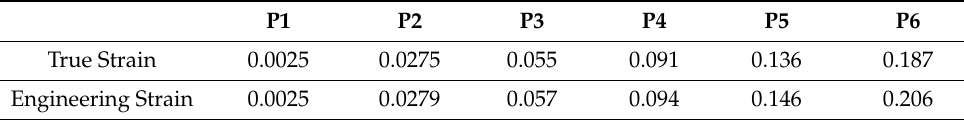
Figure 6. The true stress-strain curve and strain hardening rate-true strain curve. Table 2. The six compression strain points for further microstructure